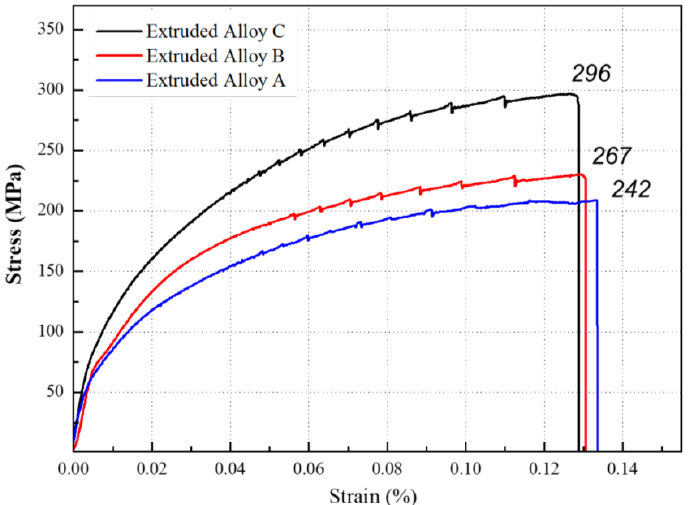
Figure 4. Comparison of tensile strength between the extruded Al-XSi-3Cu-0.6Mg-0.5Fe [X = (A): 10, (B): 12.6, (C): 14] alloys before heat treatment.